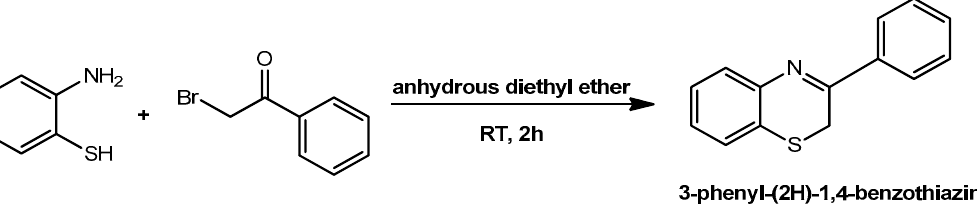
Table 1. Optimization of reaction condition for the synthesis of cyanine 1 .